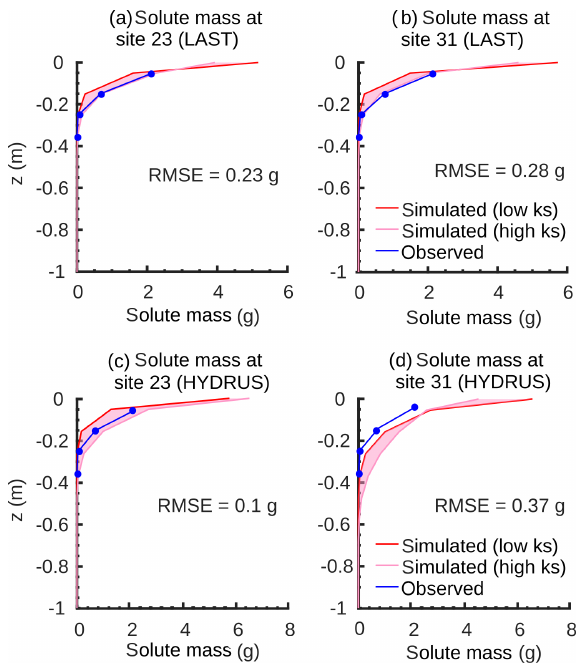
Figure 5. Final simulated and observed vertical bromide mass pro- files of the matrix at the two well-mixed sites 23 and 31 (a, b) with RMSE values simulated with the LAST-Model. In comparison, fi- nal simulated and observed vertical bromide mass profiles at the two well-mixed sites 23 and 31 (c, d) with RMSE values simulated with HYDRUS 1-D. The rose shaded area shows the uncertainty area of measured k s values.